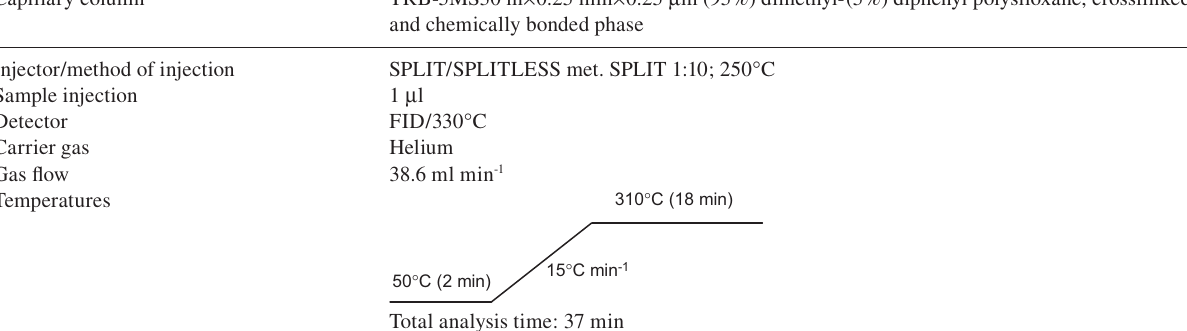
Table 2 Chromatographic conditions. Capillary